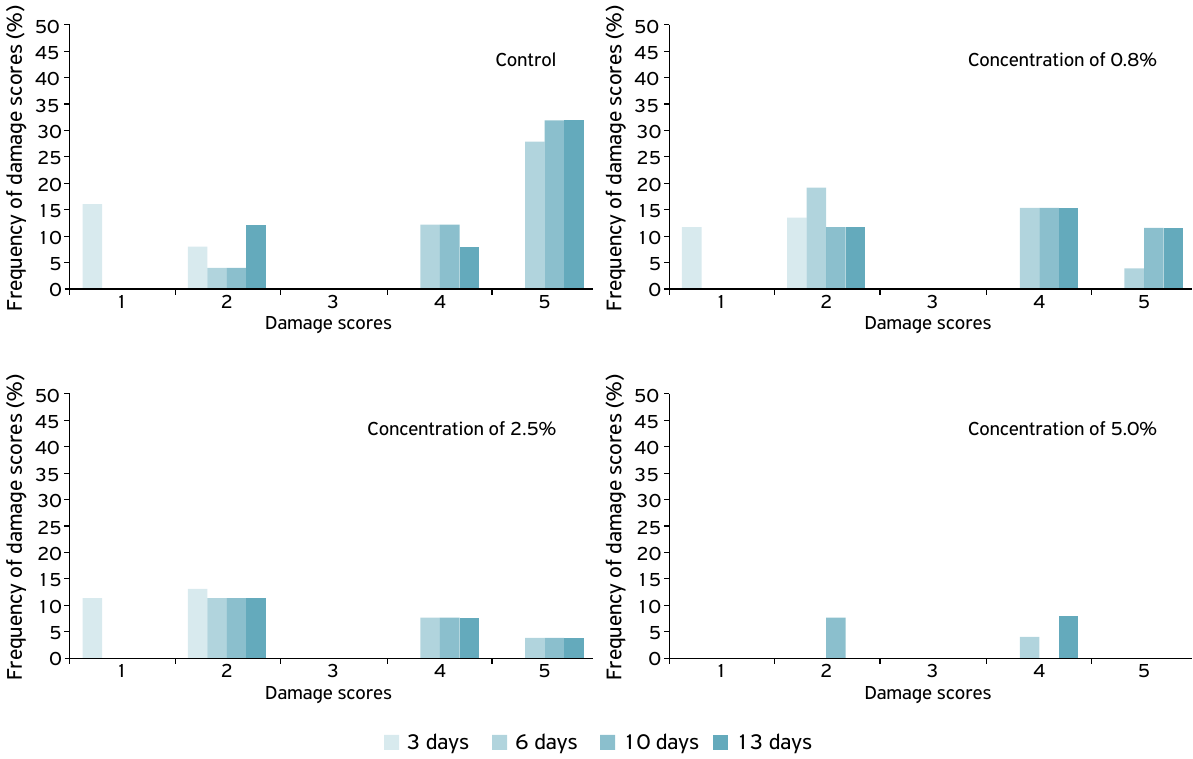
Figure 1. Frequency distribution for the damage scores attributed to Spodoptera frugiperda feeding on corn plants 3, 6, 10, and 13 days after the first spraying with different concentrations of an aqueous extract of pequi ( Caryocar brasiliense ) fruit peels or water (control).